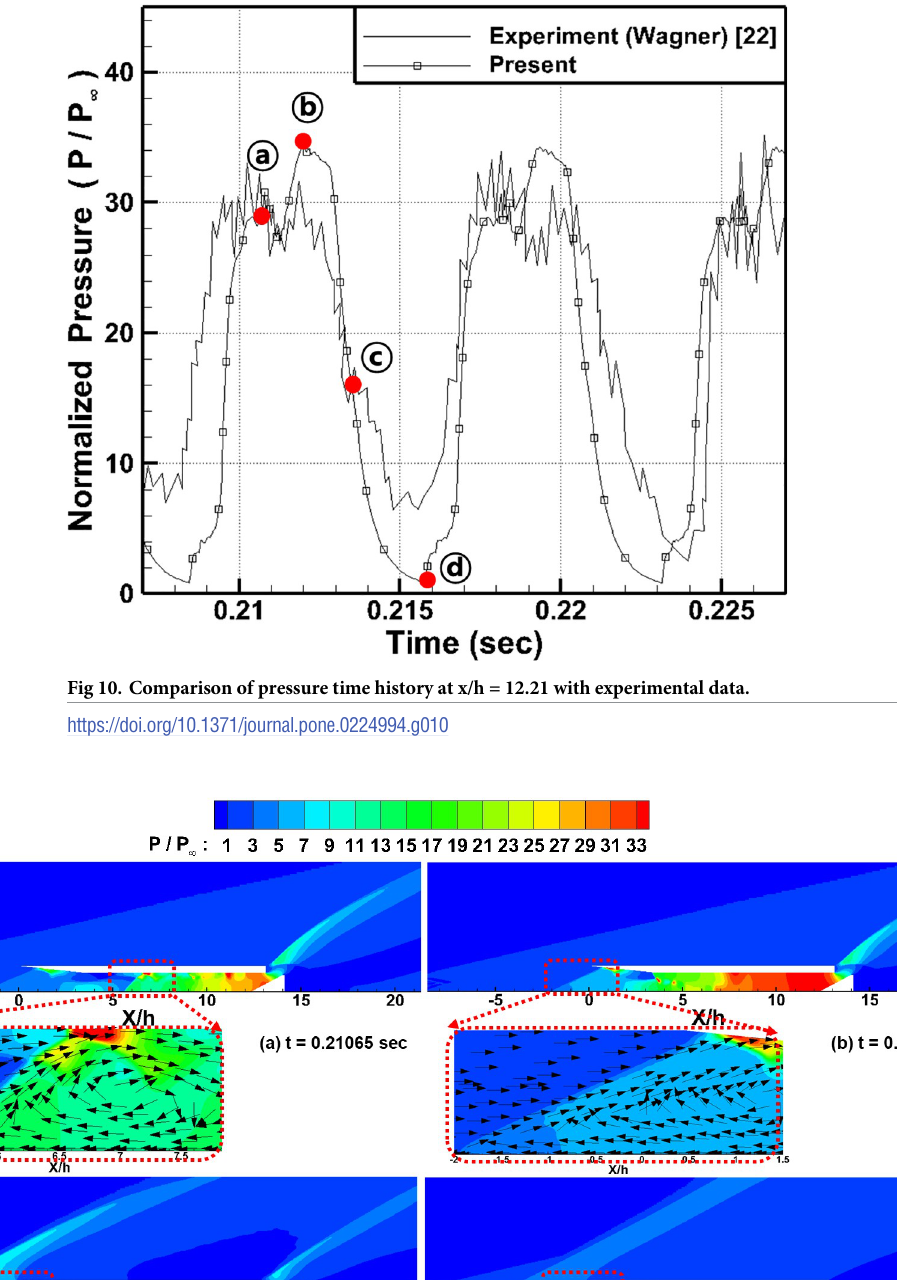
PLOS ONE | https://doi.org/10.1371/journal.pone.0224994 November7,